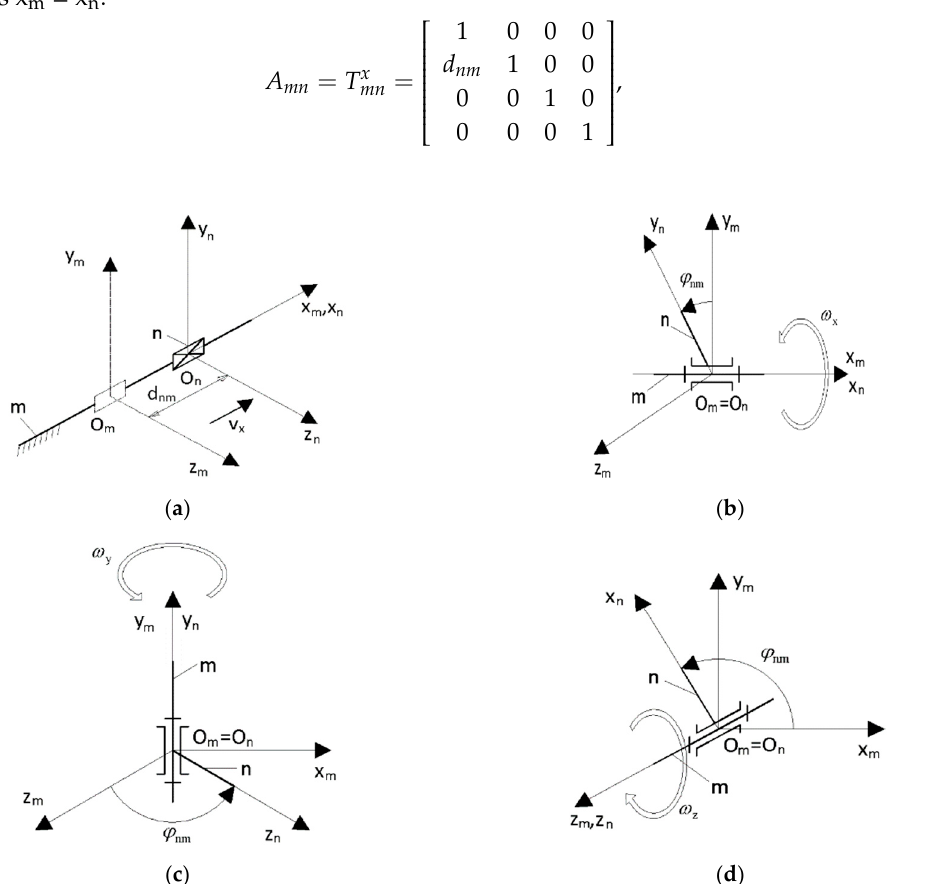
Figure 7. Appropriate kinematic schemes for homogeneous elementary operators: ( a ) translation; ( b ) rotation by x axis; ( c ) rotation by y axis; ( d ) rotation by z axis.